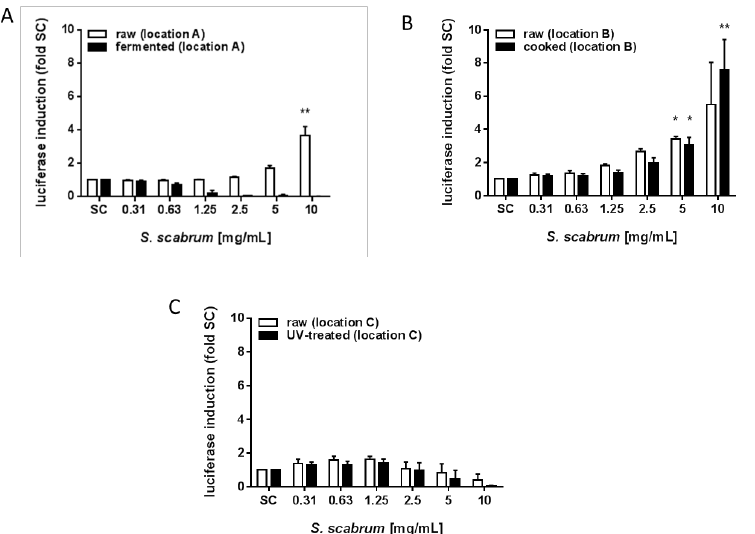
Figure 5. Induction of ARE/Nrf2- mediated gene expression by ethanolic extracts of S. scabrum (raw, processed and UV-C treated). Results are fold induction of luciferase as indicator of ARE/Nrf-2-mediated gene expression. Luciferase induction is given for ( A ) raw vs. fermented, ( B ) raw vs. cooked and ( C ) raw vs. UV-treated S. scabrum leaves. Data are means ± SEM of three independent experiments expressed as fold control (SC: solvent control, 0.7% ethanol). Asterisks indicate statistically significant differences between the respective treatment and the solvent control p ≤ 0.05 (*) p ≤ 0.01